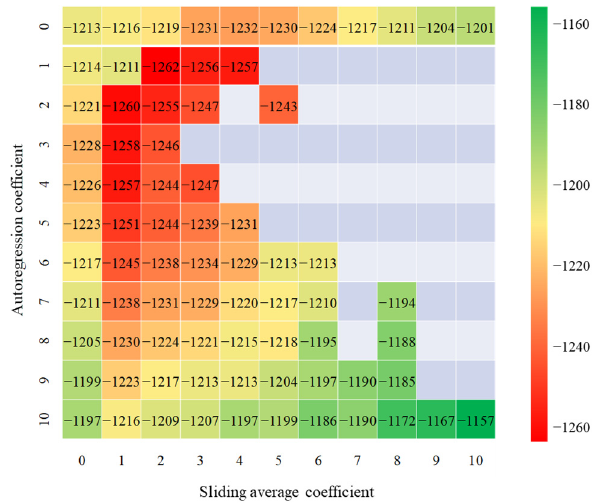
Figure 4. Bayesian information criterion (BIC) thermal diagram for the 10-min DNI clear sky indexes time series.